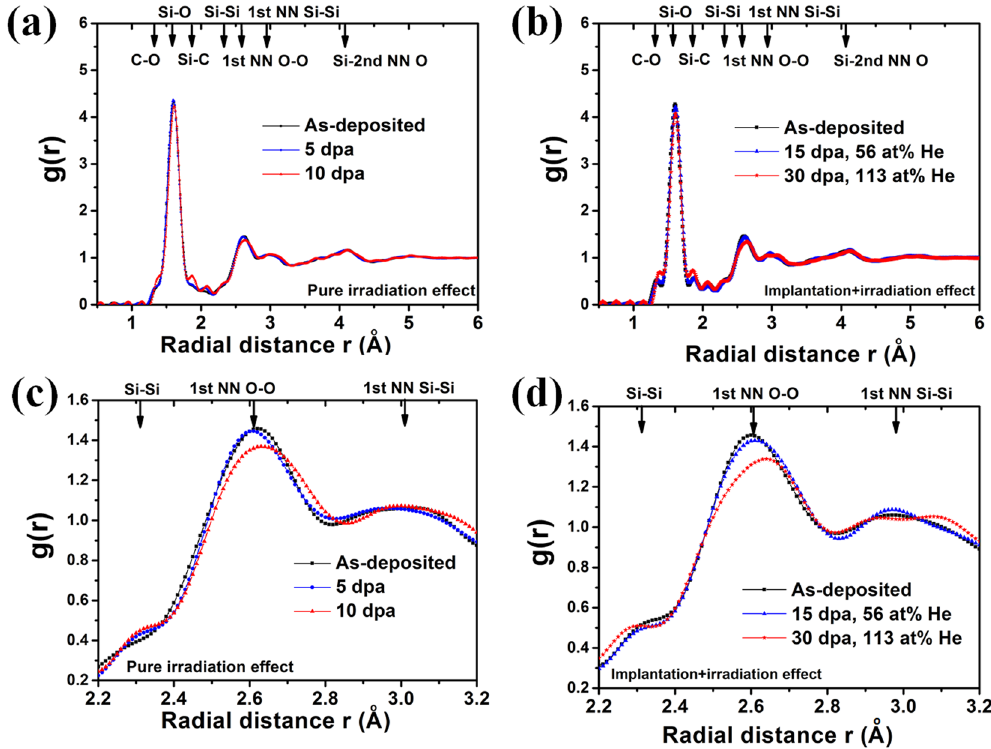
Figure 3. The PDF of SiOC film before and after ( a ) irradiation and ( b ) implantation. The magnified PDF of SiOC film before and after ( c ) irradiation and ( d ) implantation at the range from 2.2 to 3.2 Å.